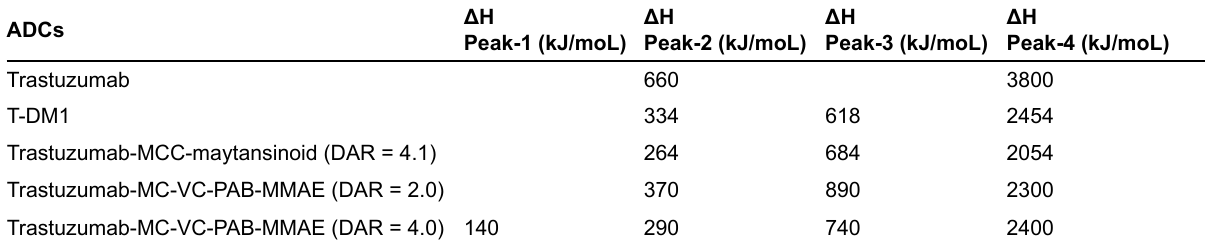
Table 5. Enthalpy fit parameters of the supplied ADC samples